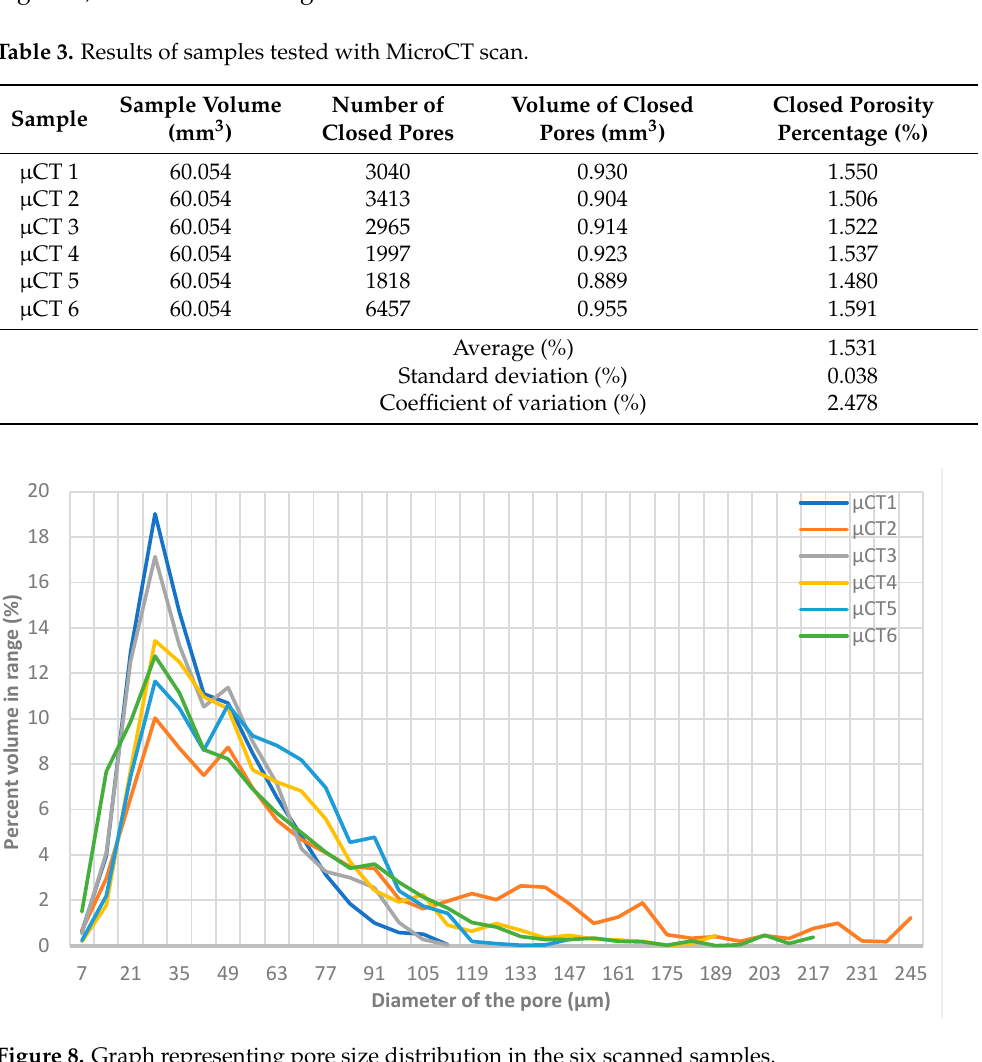
Figure 8. Graph representing pore size distribution in the six scanned samples. Table 3. Results of samples tested with MicroCT scan.